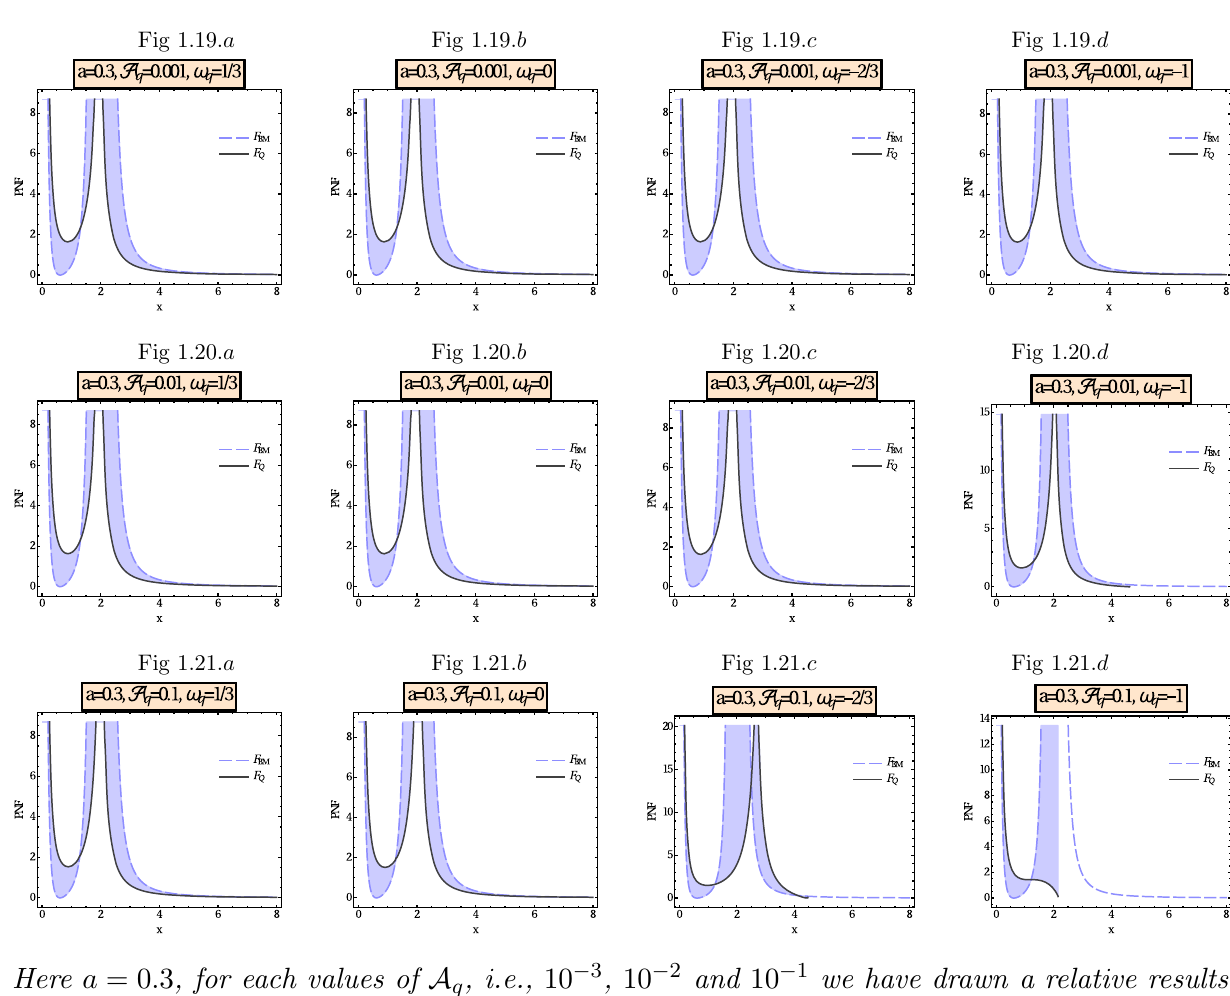
Fig 1 . 19 .a Fig 1 . 19 .b Fig 1 . 19 .c Fig 1 . 19 .d